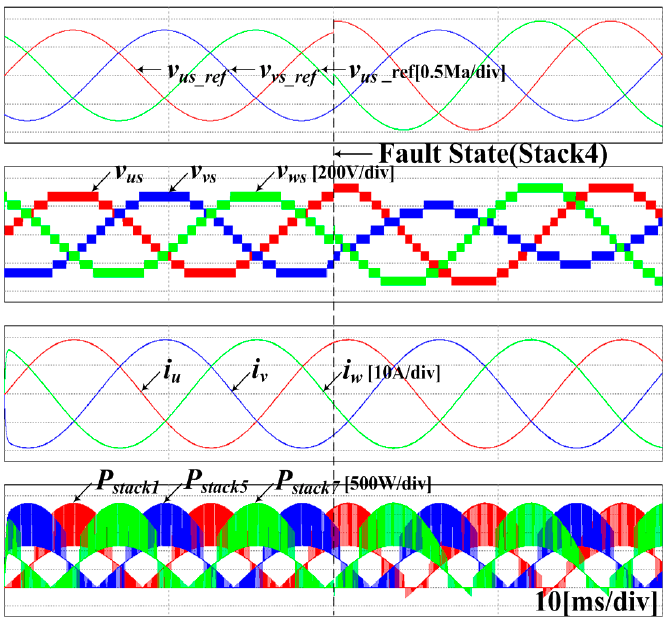
Figure 19. Simulation waveform of individual stack power when V phase fourth stack fails in applying the conventional neutral-point voltage-shifting control. Table 2. Comparison of RMS values of average output power and reference voltage when fourth stack fails in applying the conventional neutral-point voltage-shifting control.